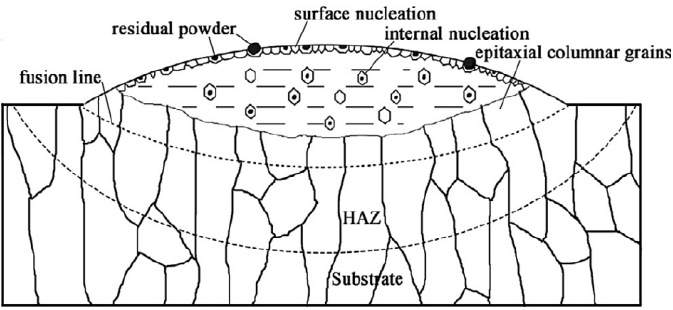
Figure 5. Schematic illustration of the two dominant solidification mechanisms within a local melt pool [22]. melt pool